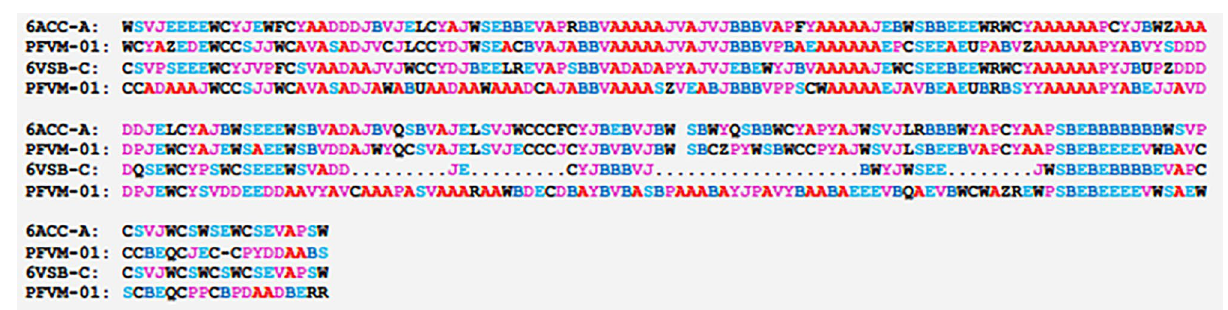
Table 5. The alignment of PFSC strings between PDB 6ACC-A-306–527 for SARS-CoV and PDB 6VSB-C- 319–541 for SARS-CoV-2, and the most likely folding conformation (PFVM-01) from PFVM. The left column indicates the structure names. Two of PFVM-01 are the PFSC strings taken from the first row of PFVM in Table 4. In PFSC letters, the red and pink represent alpha helix and like helical fold; the blue and light blue for beta strand and like beta